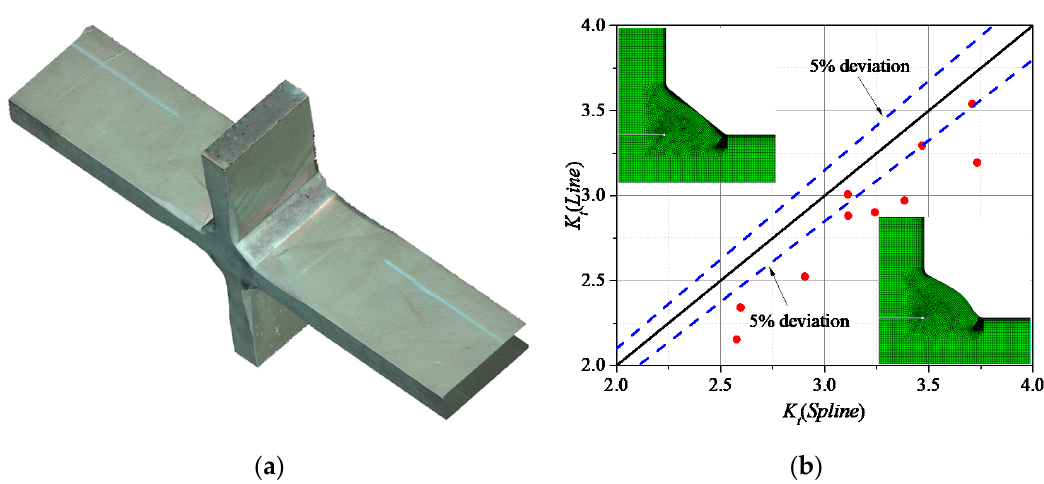
Figure 4. Comparison between the spline model and line model: ( a ) scanned cruciform specimen; ( b ) deviation ratio.